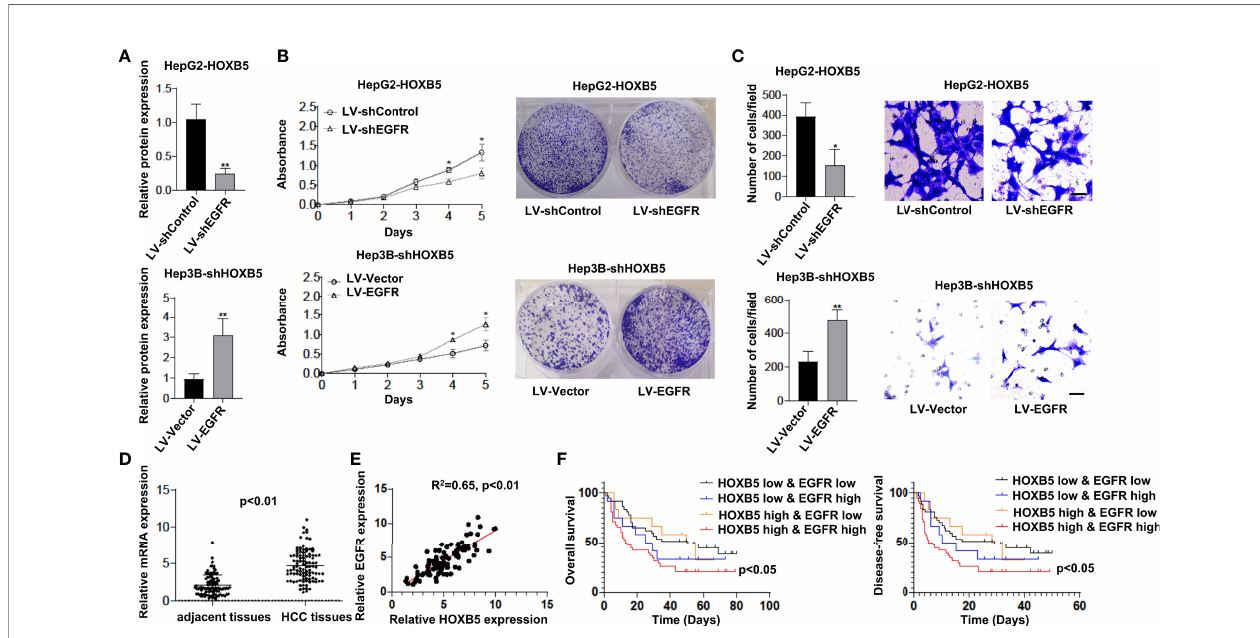
FIGURE 4 | HOXB5 promotes HCC progression by upregulating EGFR expression, and positively correlated with EGFR expression in human HCC tissues. (A) Expression of EGFR in HepG2-HOXB5 and Hep3B-shHOXB5, and their corresponding control cell lines as tested by Western bolt. Data are mean ± SD. **p < 0.01; (B) CCK8 and clonogenicity assays of proliferation capability of HCC cells. Data are mean ± SD. *p < 0.05; (C) Migration assay of HepG2-HOXB5 and Hep3B-shHOXB5, and their corresponding control cell lines as tested by transwell experiment. Data are mean ± SD. *p < 0.05, **p < 0.01. Scale bars, 100µm; (D) mRNA expression level of EGFR in 100 pairs of HCC tissues and adjacent non-tumor tissues was evaluated by qRT-PCR. Data are mean ± SD, n=100; (E) EGFR expression is positively corelated with HOXB5 expression; (F) Kaplan-Meier analysis showed that HCC patients with positive co-expression of EGFR and HOXB5 showed lowest OS and DFS